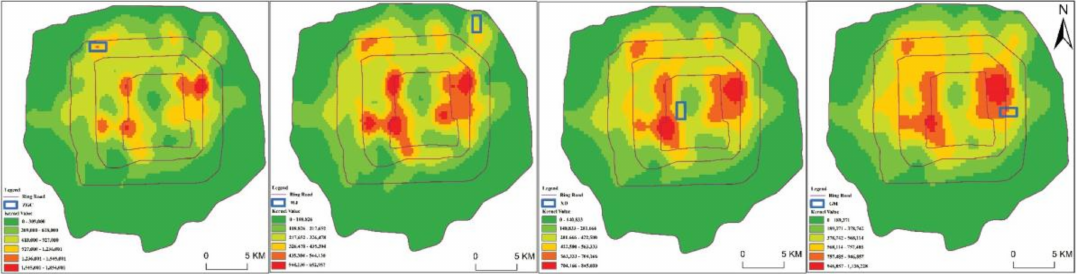
Figure 7. Hotspot maps for the intensities and ranges of interactions among the four functional